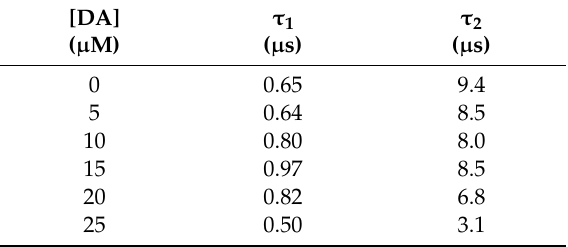
Figure 3. Fluorescence response of ( a ) QDs@MIP and ( b ) QDs@NIP particles with increasing concentrations of dopamine (DA). ( c ) Stern–Volmer description of the data obtained with QDs@MIP particles showing a linear fit throughout the DA concentration range. The calibration curve obtained with QDs@NIP particles is also given for comparison. Table 1. Time constants τ 1 and τ 2 of QDs@MIP particles vs DA